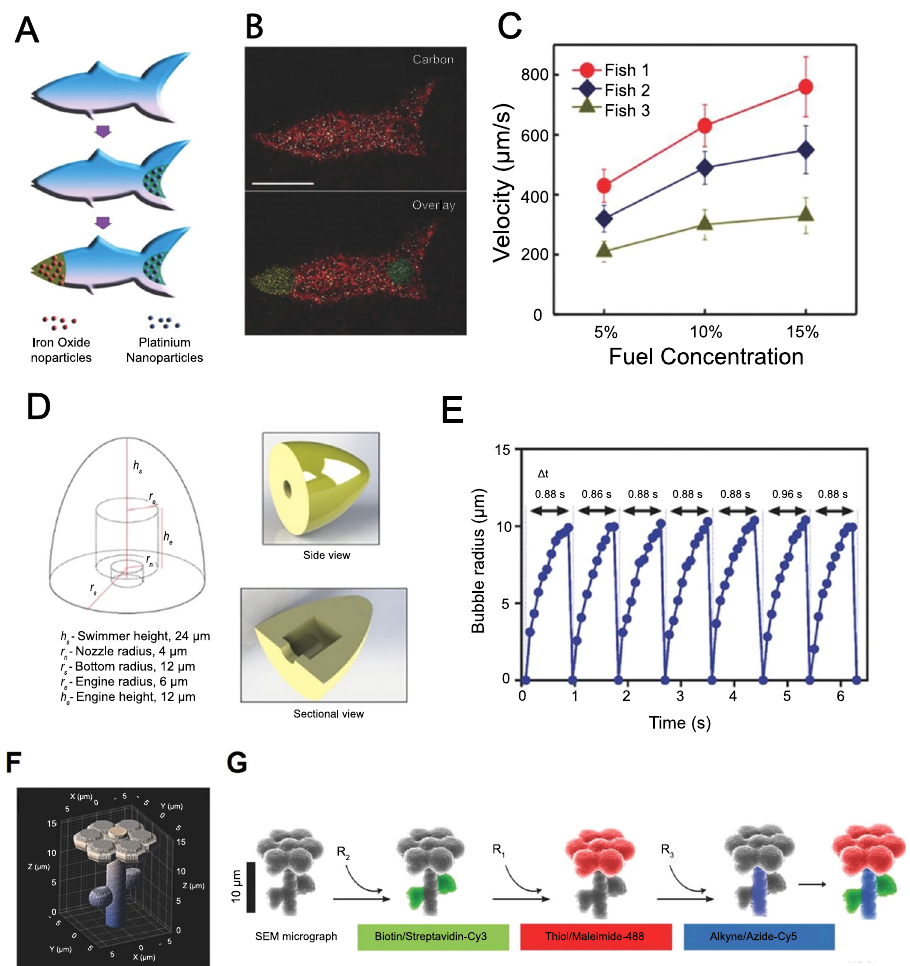
Fig. 4 | 3D printing of more complex microrobots. A – C Three-dimensional (3D) printed arti fi cial fi sh propelled with catalytic impulsion. A Functionalization of micro fi shes. Platinum (Pt) nanoparticles were loaded to the tail of the fi sh using catalytic decomposition for propulsion. Subsequently, to enable magnetic actua- tion/control, Fe3O4 nanoparticles were loaded on the head of the fi sh. B Energy- dispersive X-ray (EDX) spectroscopy images of poly (ethylene glycol) diacrylate (PEGDA) micro fi sh body, platinum tail, and the iron-oxide head (scale bar: 50 µ m). C Velocity plots of micro fi shes with different shapes and Pt nanoparticle con- centrations(5,10,and15%H 2 O 2 ).Fish1:common fi shwith8.0×108Ptparticlesper ml; Fish 2: manta ray with 8.0×108 Pt particles per mL; Fish 3: common fi sh